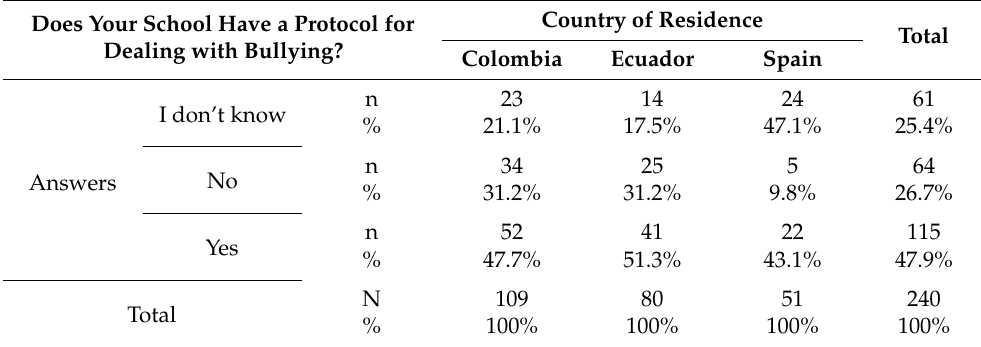
Table 3. Cross-categorization of the variable “Does your school have a bullying protocol” and the variable “Country of